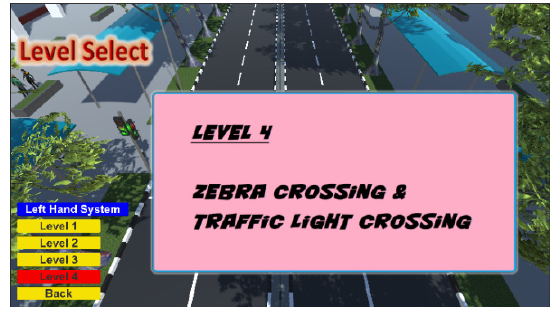
Figure 9. Level selection screen at Tutorials mode.